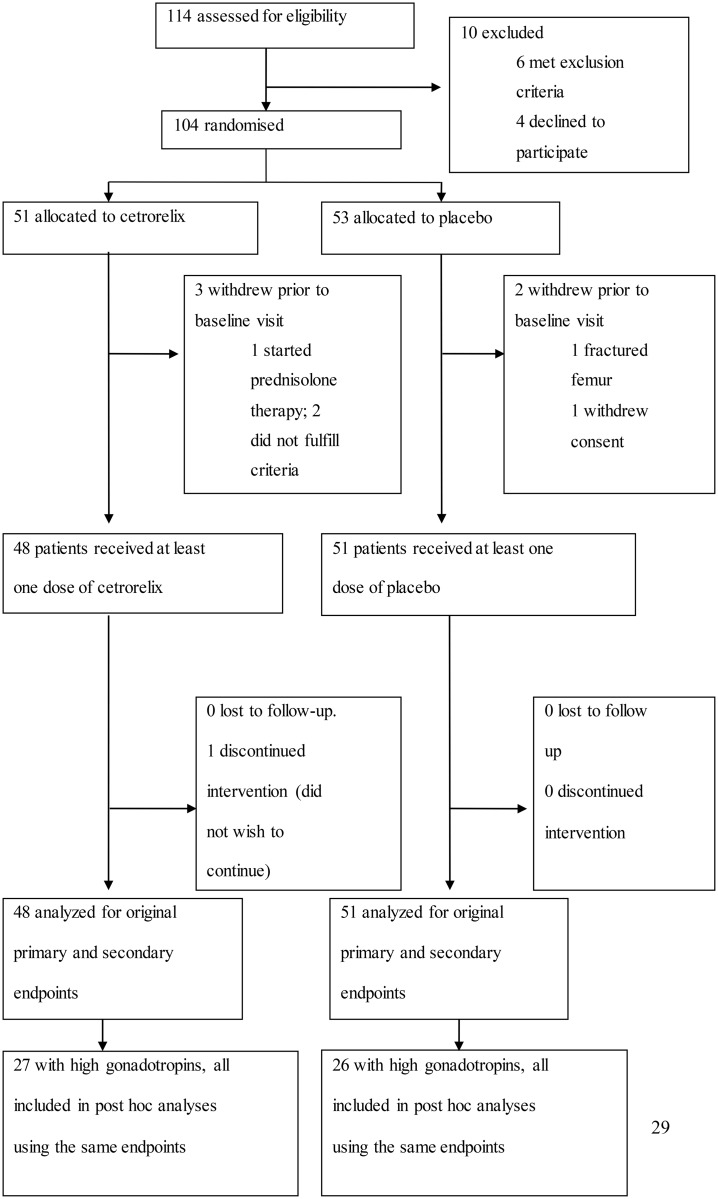
Trial Flow Chart.